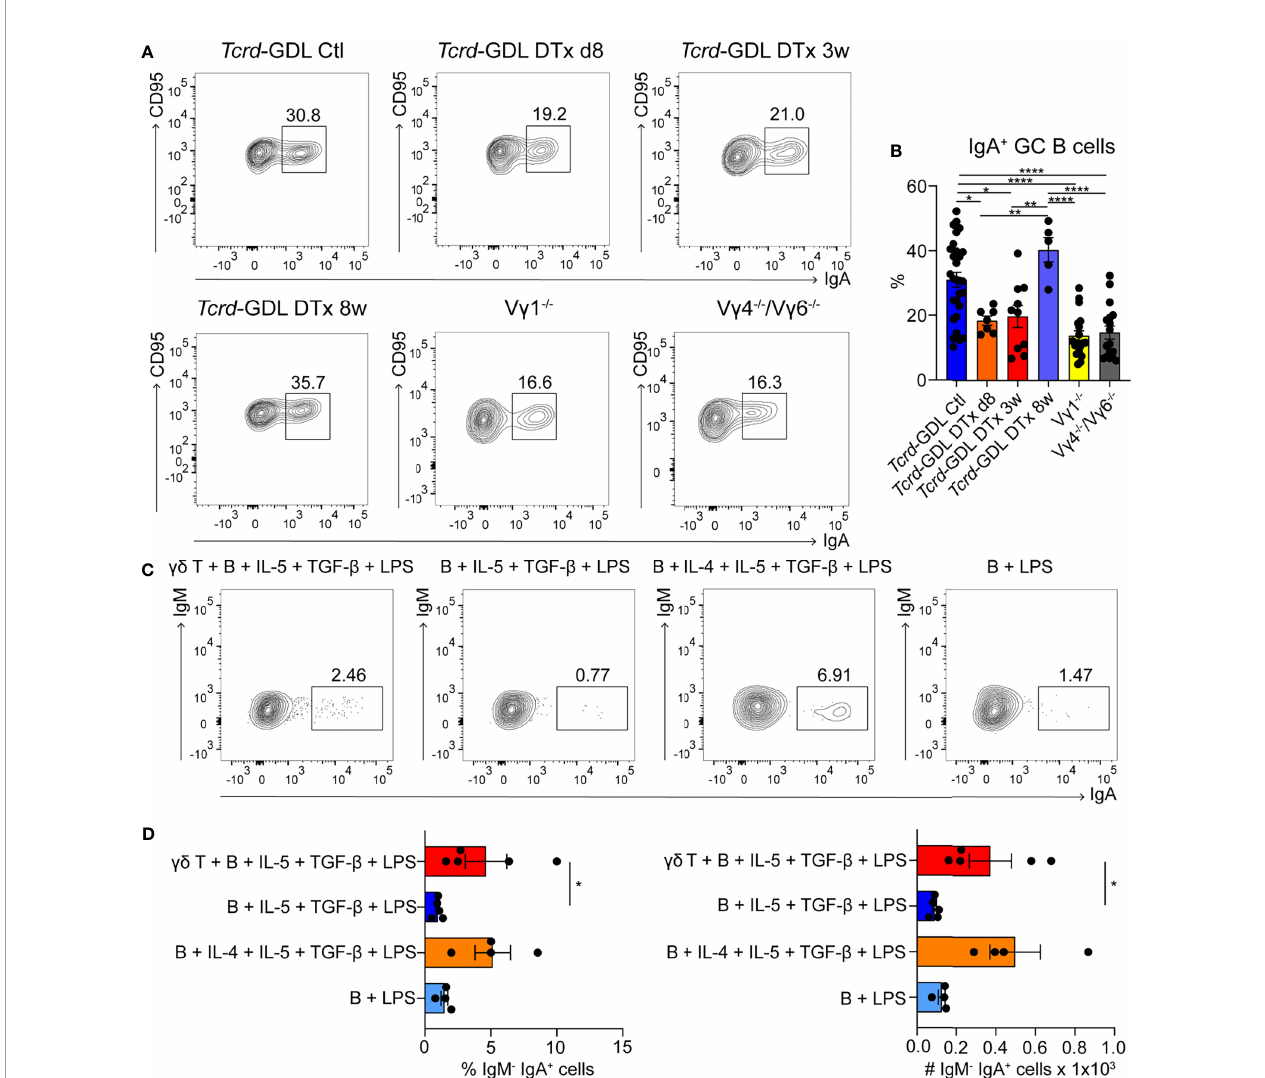
FIGURE 3 | gd T cells are involved in the generation of IgA + GC B cells. (A, B) PPs were isolated from non-depleted and gd T cell – depleted (8 days, 3 weeks, and 8 weeks) Tcrd -GDL, V g 1 − / − , and V g 4 − / − /V g 6 − / − mice. (A) FACS analysis of IgA + germinal center (GC) B cells (CD19 + , CD138 − , GL7 + , CD95 + , IgA + ). (B) Quanti fi cation of IgA + GC B cells (CD19 + , CD138 − , GL7 + , CD95 + , IgA + ). Bar graph, mean ± SEM. n = 8 – 27 per group. Each dot represents an individual mouse. (C, D) Co-culture experiments of gd T cells together with B cells isolated from PPs of Tcrd -H2BeGFP mice in the presence or absence of additional cytokines (100 ng/ml IL-4, 1 ng/ml IL-5, 1 ng/ml TGF- b ) and 10 ng/ml LPS as indicated in the graphs. To all conditions 1 ng/ml IL-6 was added 3 days after the beginning of the culture. (D) FACS analysis was performed to quantify the percentage and absolute number of membrane IgA + B cells (B220 + , CD3 − , IgM − , IgA + ) cultured in presence or not of gd T cells, LPS, and cytokines as indicated. Bar graph, mean ± SEM. n = 4 – 5. ANOVA test was applied with Tukey post-hoc test. *P < 0.05, **P < 0.01, ****P <